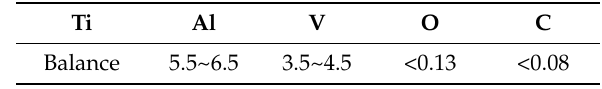
Figure 1. Scanning electron microscopy (SEM) image of Ti-6Al-4V alloy powders used for SLM. Table 1. Chemical composition of Ti-6Al-4V alloy powders (wt %).